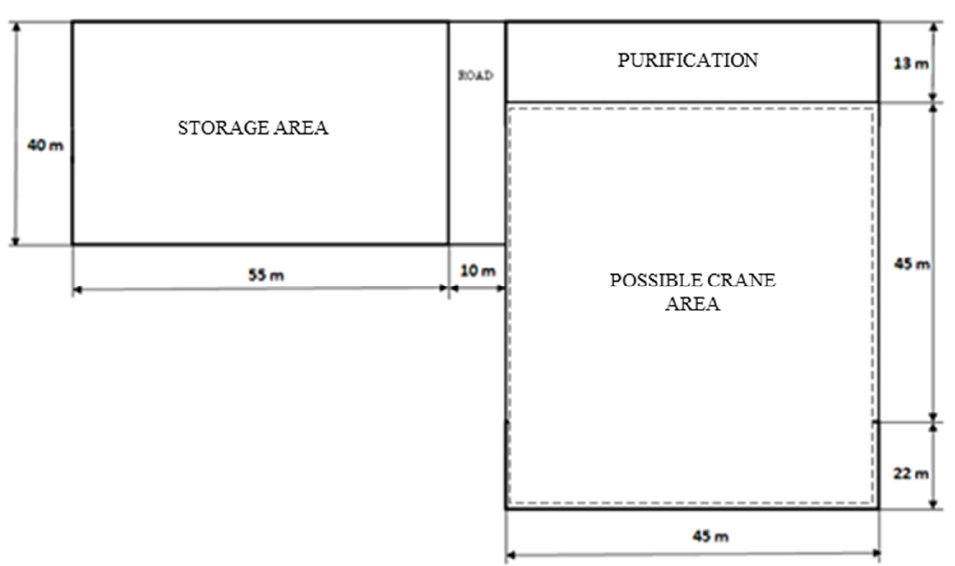
Figure 14. The layout of the areas to be used for storage.